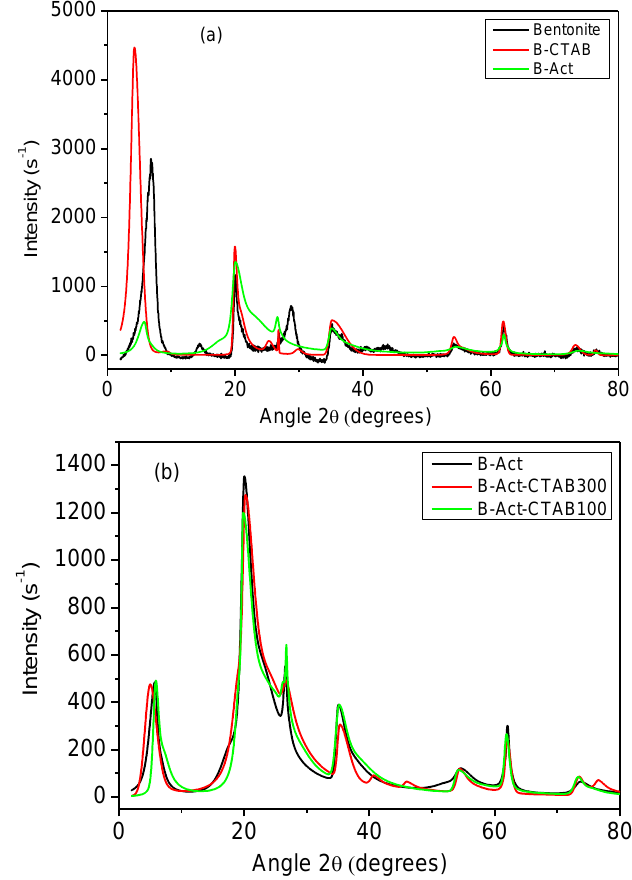
Figure 2. XRD patterns of ( a ) Bentonite, B-CTAB and B-Act; ( b ) B-Act and organo-acid-activated bentonite with different CTAB loadings corresponding to 100% and 300% CEC (B-Act-CTAB100 and B-Act-CTAB300), respectively.